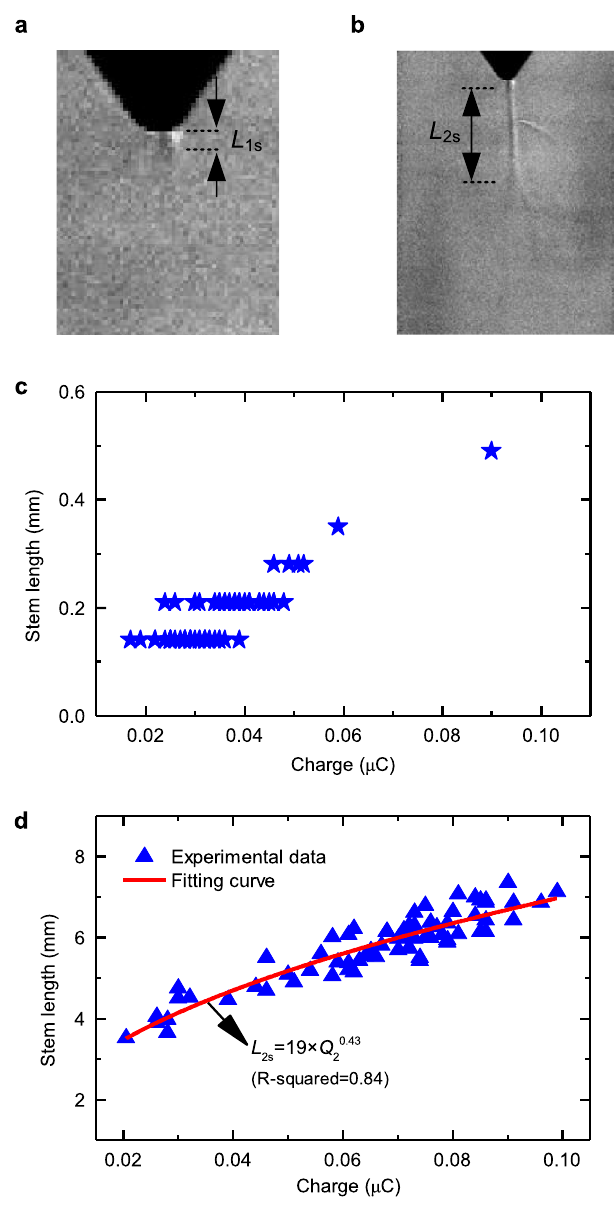
Figure 2. Stem elongation after the first and the second streamer bursts. Examples of the length measurement of stems produced by ( a ) the first burst and ( b ) the second burst. ( c ) and ( d ) show the measured stem length as a function of charge for the first and the second streamer bursts,